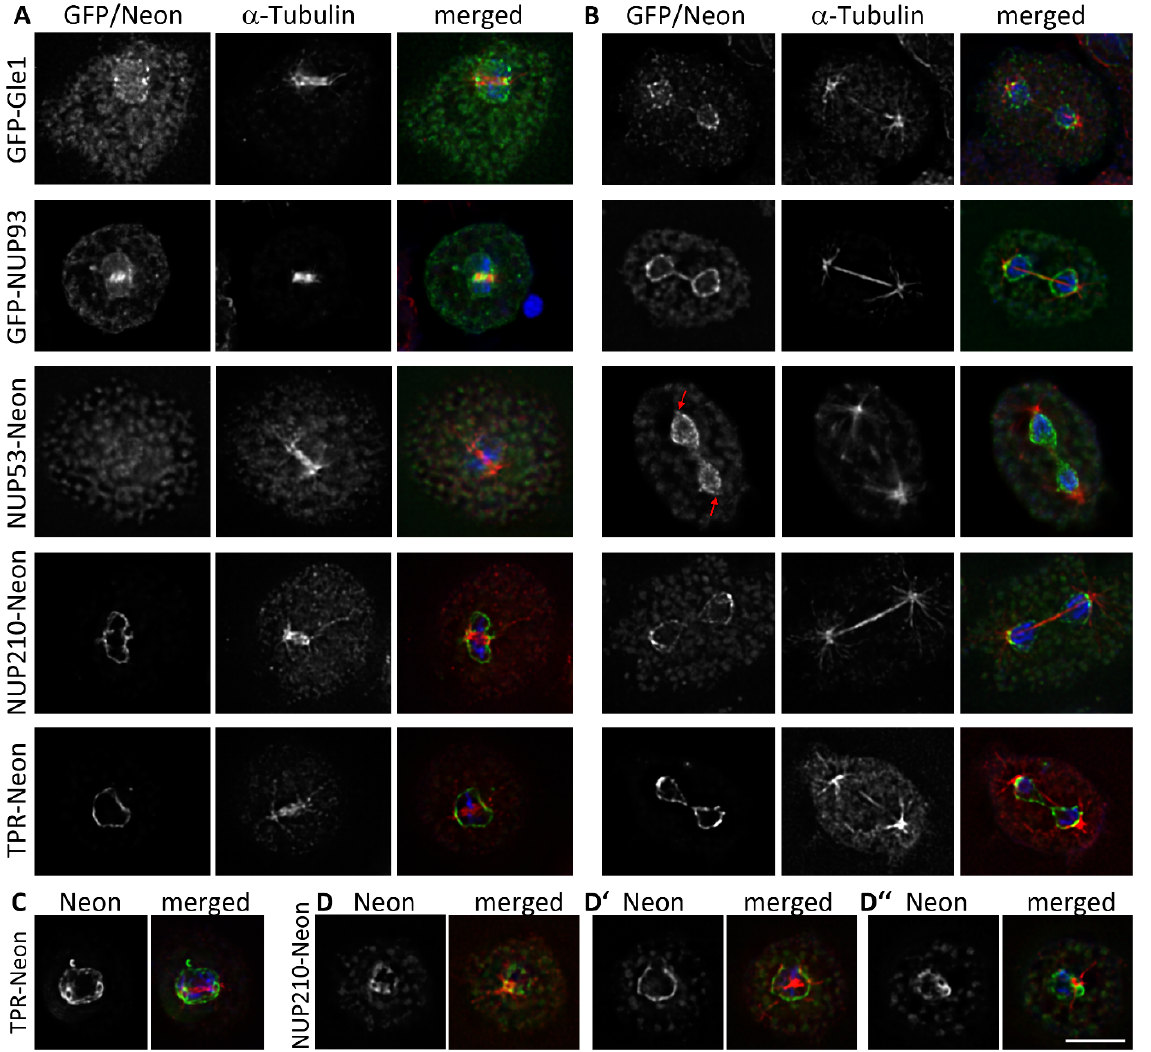
Figure 6. Overexpressed Gle1 and NUP93 localize to spindle poles. NUP53 Neon is absent from spindle poles in metaphase but reappears in telophase (red arrows). Neon-fusion proteins of NUP210 and TPR are concentrated close to the spindle poles and form a ring around the poles in metaphase. Immunofluorescence microscopy of GFP-NUP or NUP-Neon-fusion protein expressing cells in interphase fixed with glutaraldehyde, stained with anti- α -Tubulin and secondary antibodies anti- rat-AlexaFluor-568. In ( A ) only the slice with focus on the metaphase spindle is shown. In ( B , C ) projections of several Z-slices are presented. ( D ) shows three different slices of the same NUP210- Neon metaphase cell with a tilted spindle ( D : focus on the left pole, D’ focus on the centre, D” : focus on the right pole). Overlay of the green fluorescent protein signal (green) with α -Tubulin (red) and DAPI (blue). Bar = 5 µ